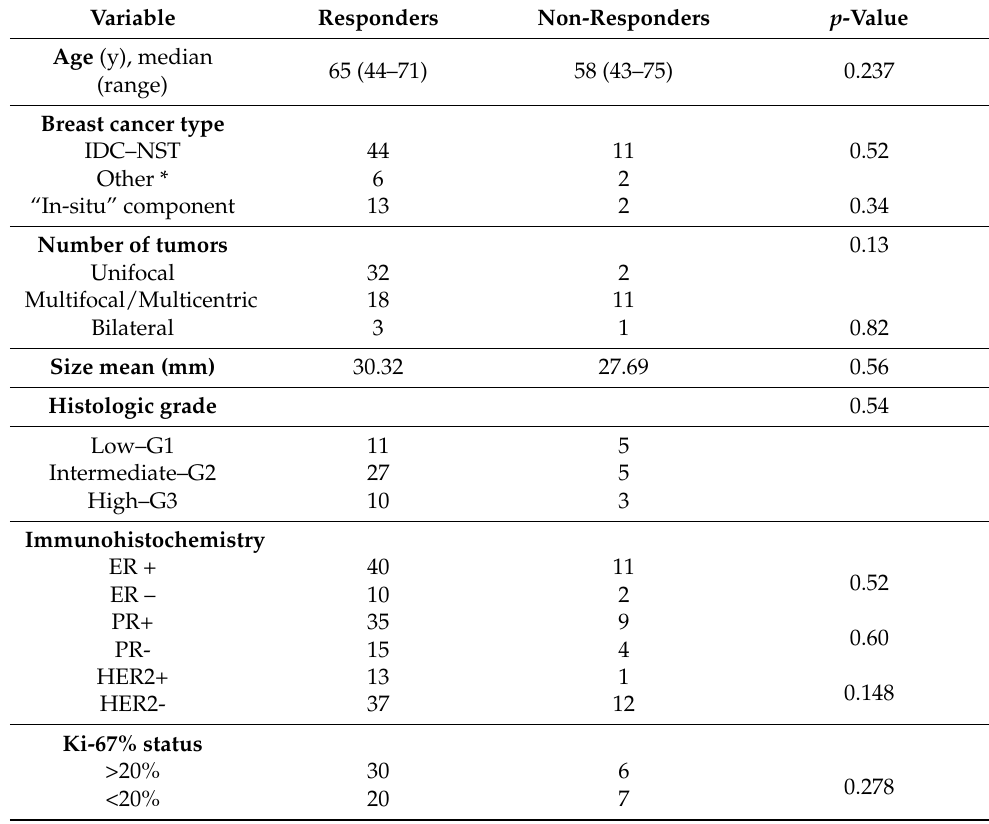
Table 1. Clinical, pathological and immunocytochemistry characteristics of responder and non-re- sponder